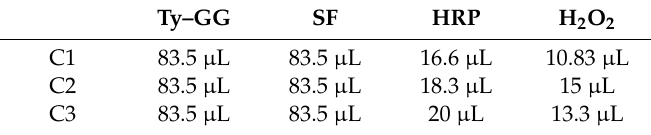
Table 1. Ty–GG and SF conditions (C1, C2 and C3) with di ff erent amounts of HRP and H 2 O 2